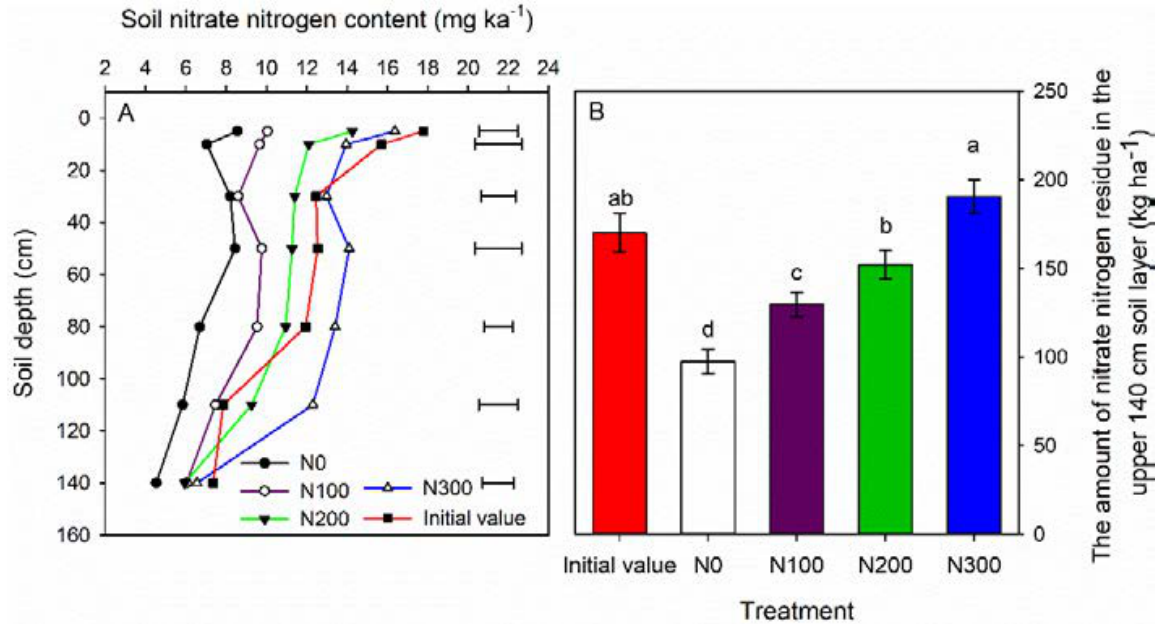
Figure 2. Effects of four rates of N application on the soil nitrate N content (mg kg − 1 ) ( A ) and the amount of nitrate nitrogen residue (kg ha − 1 ) ( B ) in the upper 140 cm soil layer in April 2012 (i.e., initial value) and October 2018. Horizontal bars denote Fisher’s protected least significant difference at p ≤ 0.05. Vertical bars indicate standard deviations of the means; bars with different letters indicate significantly different ( p ≤ 0.05).